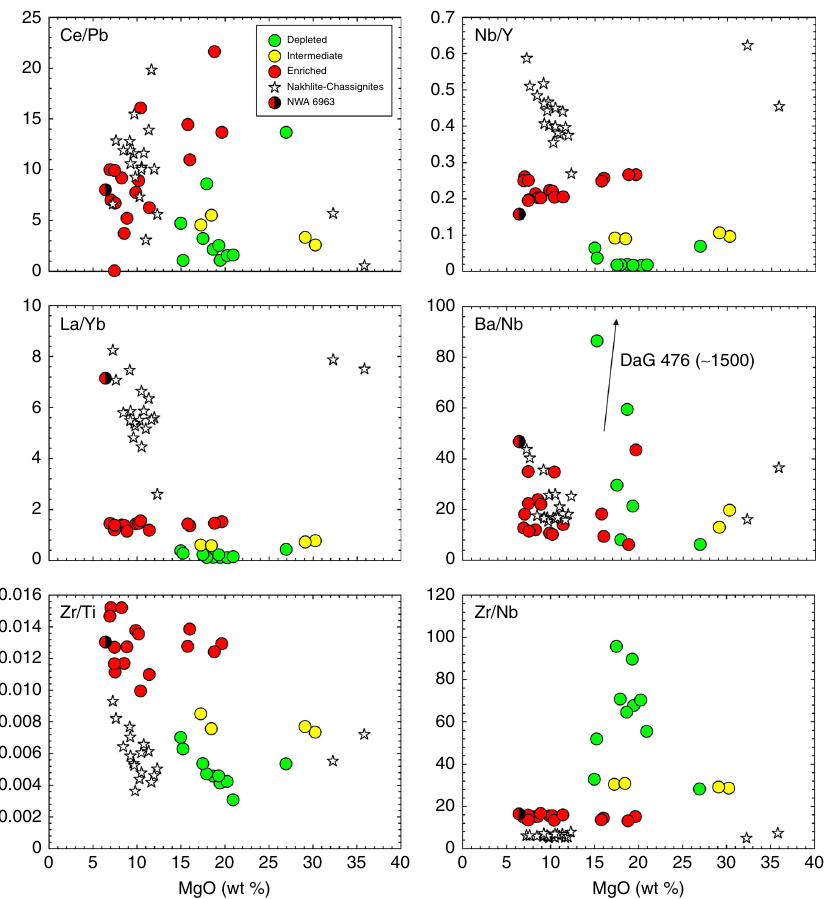
Fig. 3 MgO vs. Ce/Pb, Nb/Y, La/Yb, Ba/Nb, Zr/Ti, and Zr/Nb for shergottites, nakhlites, and chassignites. Chassignite meteorites are star symbols with >30 wt % MgO. Data are from this study and analytical uncertainties are smaller than